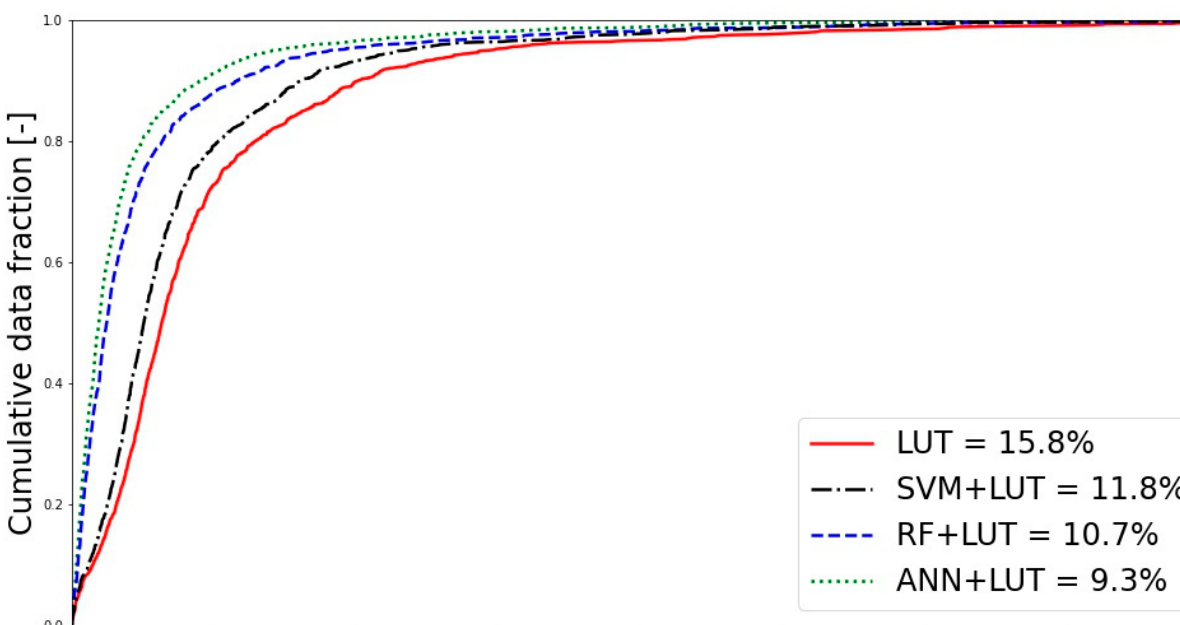
Figure 8. Test rRMSE of CHF models .